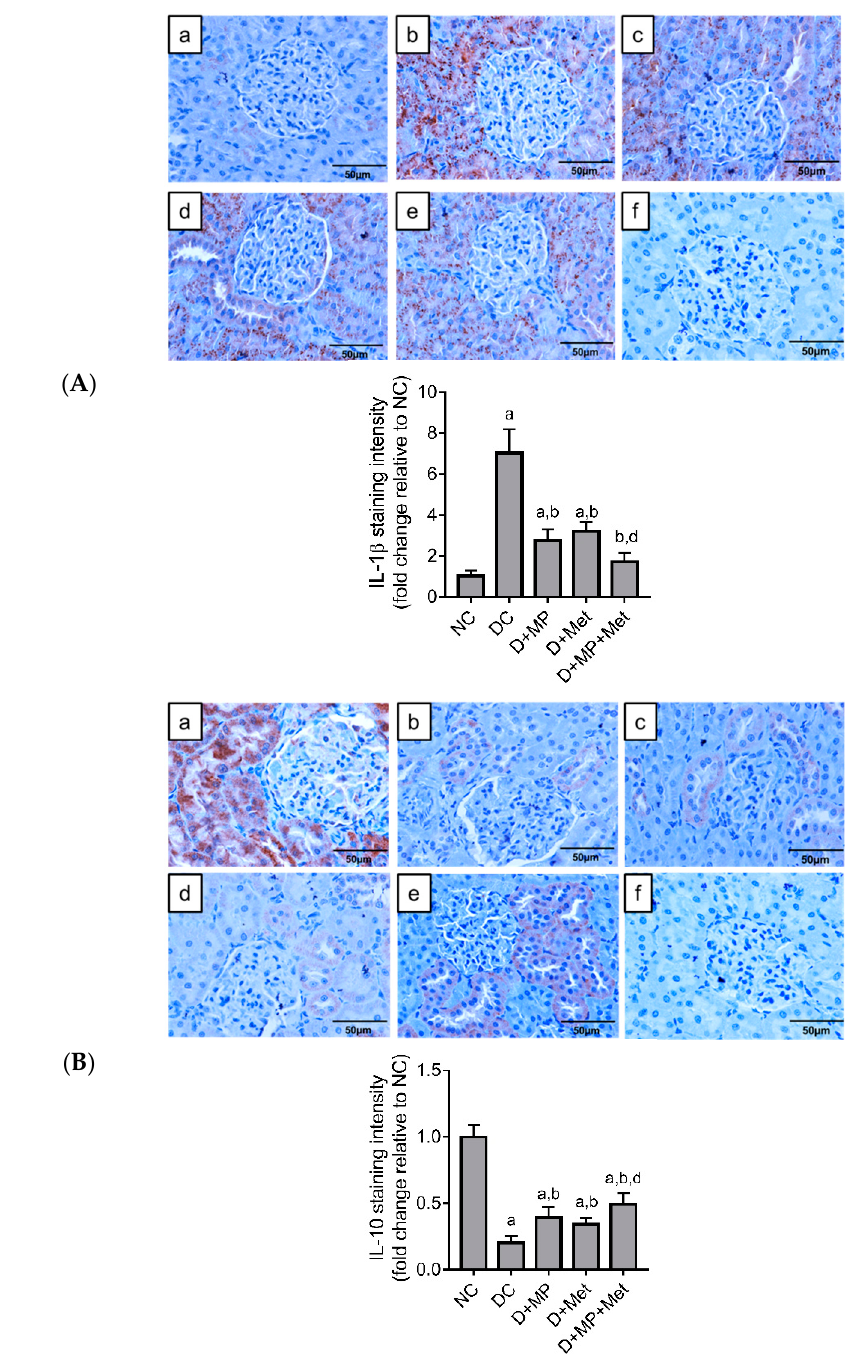
Figure 6. Immunoexpressions of interleukin-1 β ( A ) and interleukin-10 ( B ) in the kidney of diabetic rats. (a) NC, (b) DC, (c) D + MP, (d) D + Met and (e) D + MP + Met groups. Negative control is presented as (f). Photographs were taken at 400× magnification (scale bar = 50 µ m). For quantitative data, 5 photographs were analyzed per slide using ImageJ software. The expression levels were expressed as fold change relative to NC group. Values are mean ± SD, n = 6; a p < 0.05 versus NC; b p < 0.05 versus DC, d p < 0.05 versus D + Met (one-way ANOVA, followed by Tukey post hoc test).